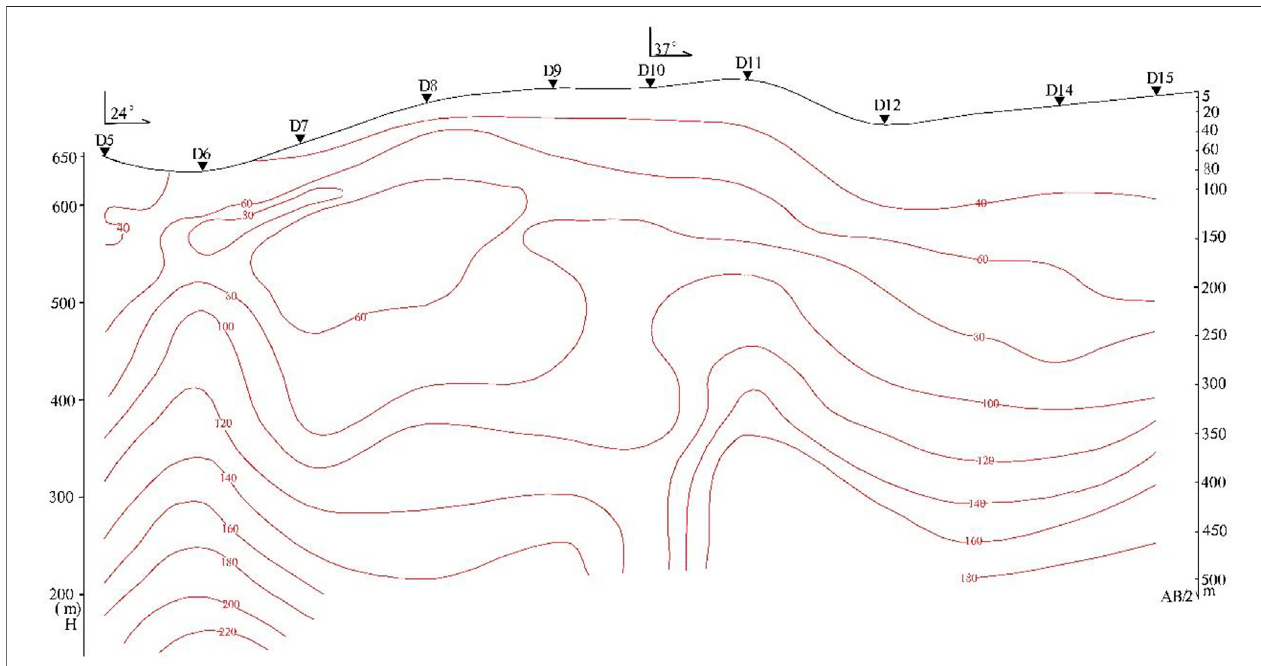
FIGURE 7 | Apparent resistivity section of the DC sounding.